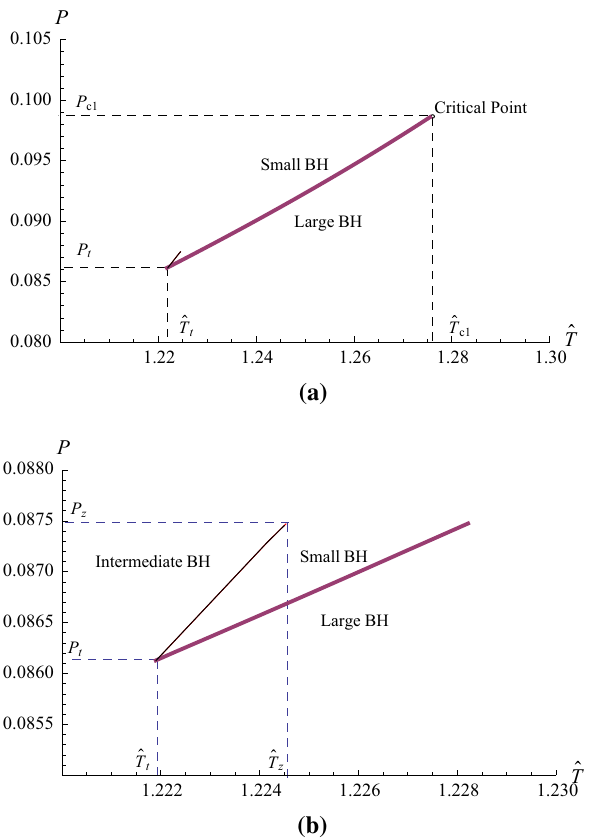
Fig. 4 The P − ˆ T diagram of six-dimensional AdS black holes for w = − 1, w = 1 and w = − 0 . 7. The coexistence line of Van 2 3 4 der Waals-like phase transition is depicted by a thick solid line , which initiates from the critical point ( P c 1 , ˆ T c 1 ) and terminates at ( P t , ˆ T t ) . The solid line in the inset indicates the coexistence line of small and intermediate black holes, separated by a finite gap in G , indicating the RPT. It commences from ( P z , ˆ T z ) and terminates at ( P t , ˆ T t )